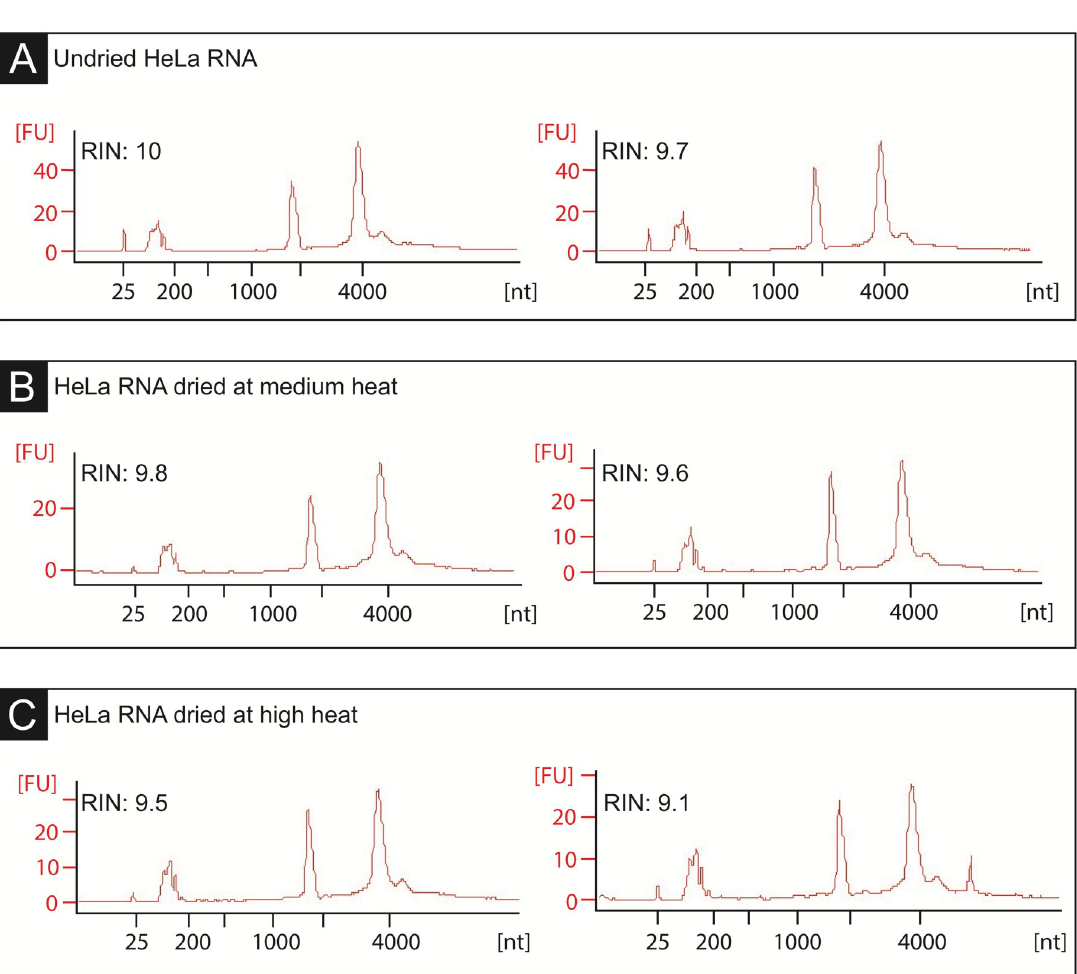
Fig 2. Dehydrated RNA demonstrates preserved integrity. Bioanalyzer traces and RNA Integrity Numbers (RINs) of biological replicates of HeLa RNA. (A) Before being dried in a vacuum evaporator. (B) After being dried for 30 minutes at 40˚C. (C) After being dried for 25 minutes at 65˚C. RINs indicate that RNA quality is not compromised during the dehydration